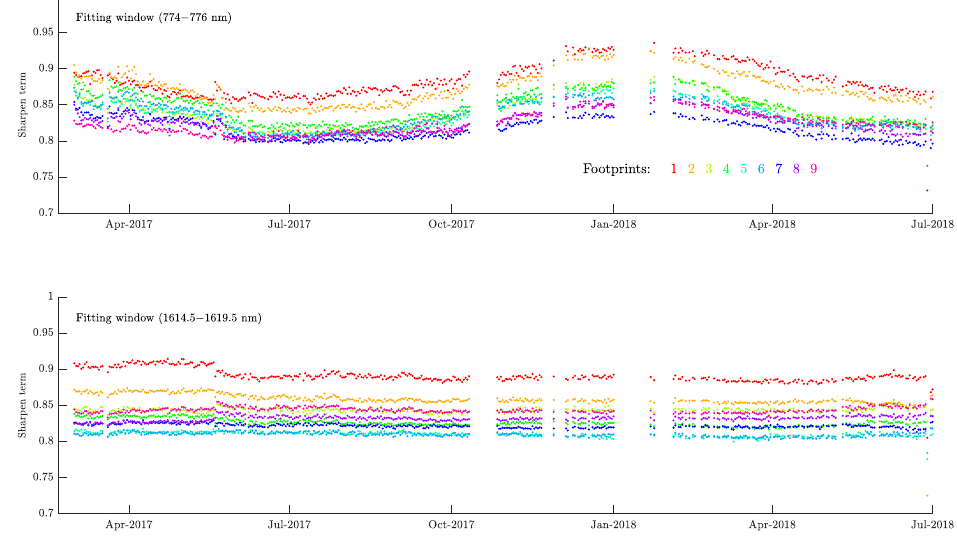
Figure 8. Similar to Figure 7 but for 6 fitting windows at the WCO2 band.